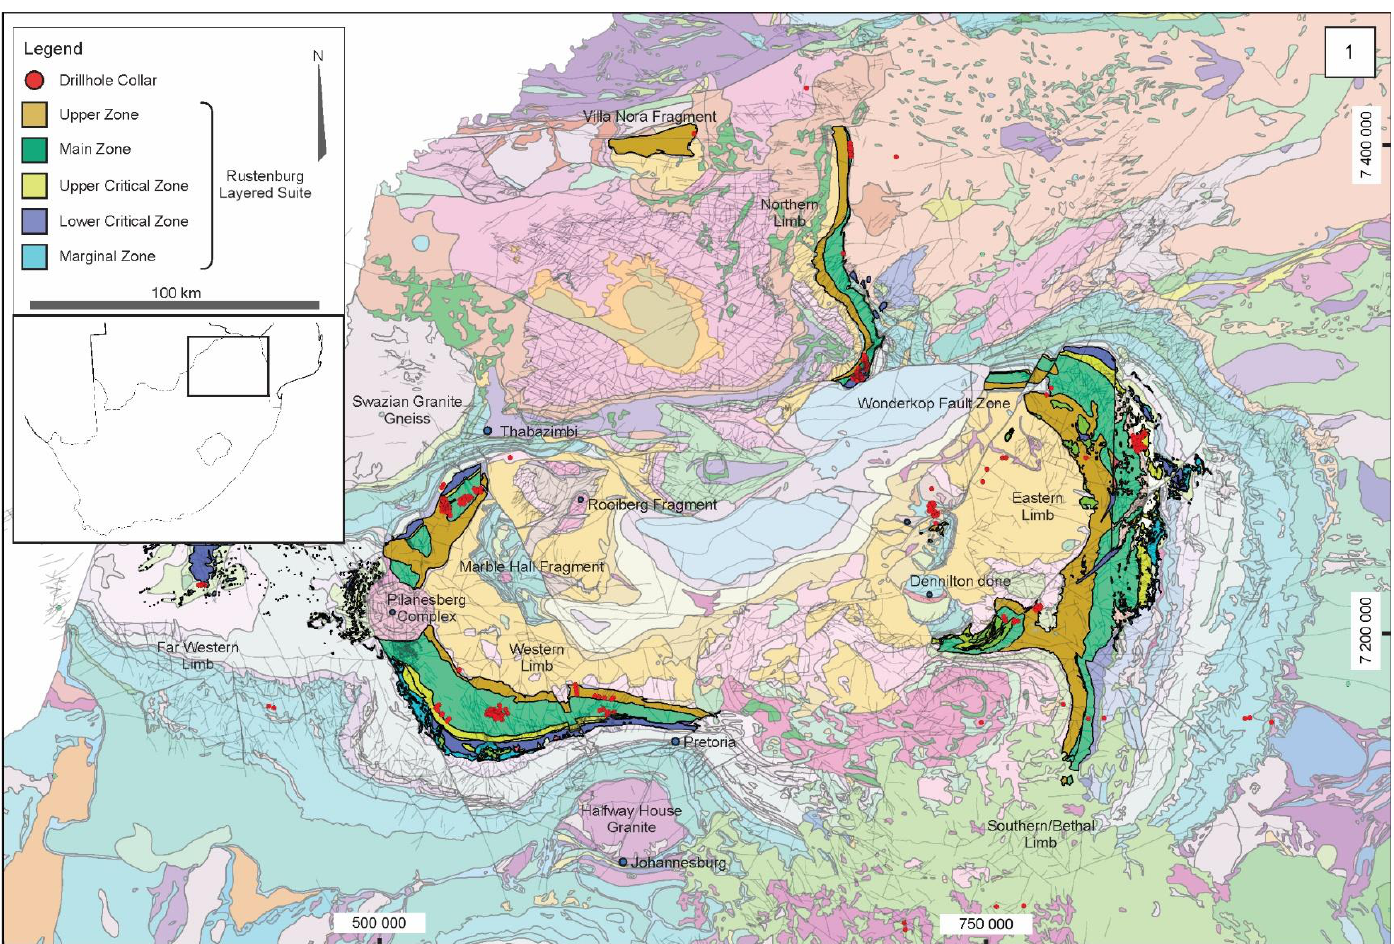
Figure 1. Overview of the Bushveld Complex, indicating the position of its primary limbs: Eastern, Western, Northern, Southern/Bethal, and Far Western. The Eastern and Western Limbs, constituting the main chamber of the complex, are hosted in Pretoria Group sediments, to the east and west, respectively. Lithologies from the open-source Council for Geosciences’ (CGS) ArcMap project, with the position of the Rustenburg Layered Suite highlighted.